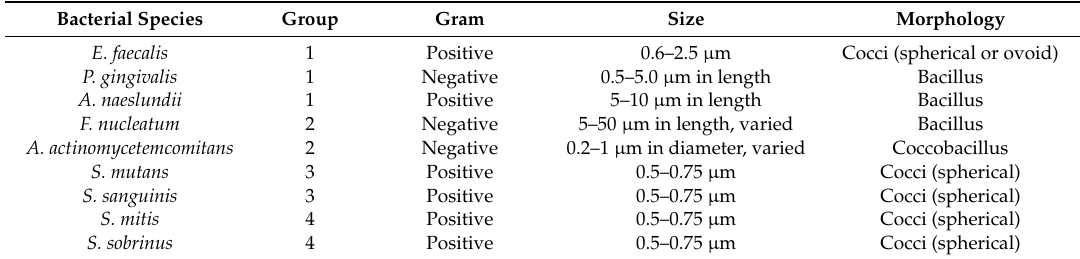
Table 1. Sizes and morphologies of tested bacterial